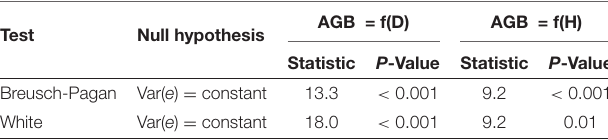
TABLE 3 | Results from the statistical tests applied to the residuals of both bivariate methods to assess